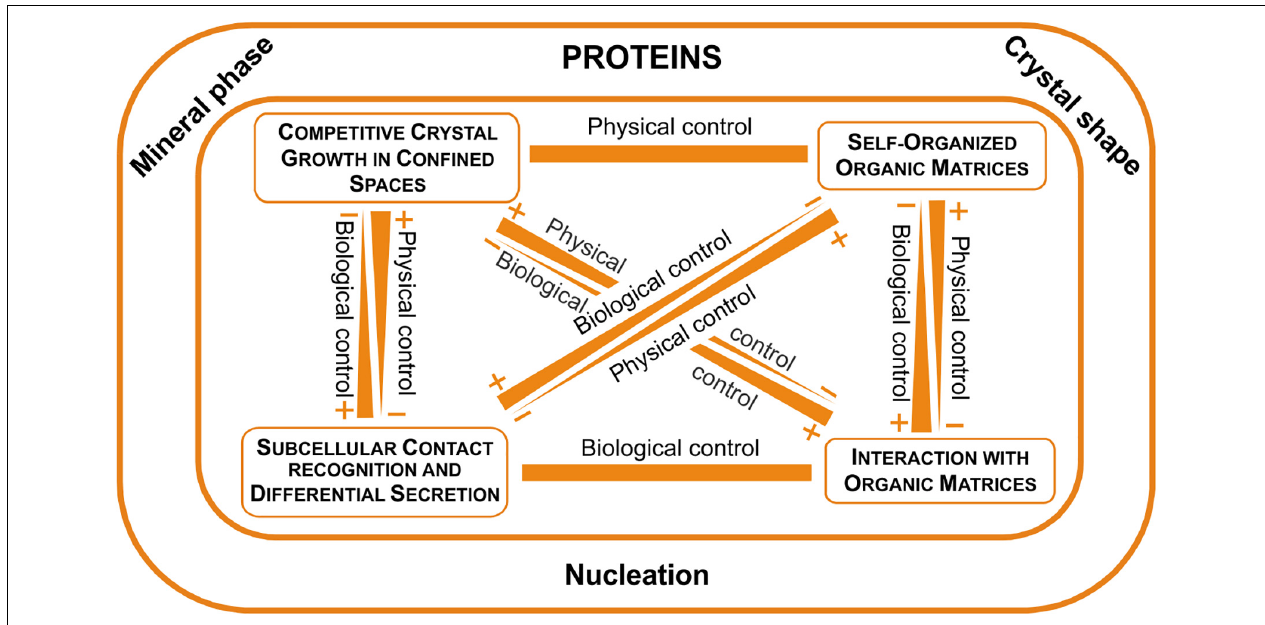
FIGURE 11 | The fabricational space of molluscan microstructures. Proteins clearly determine the mineral phase, crystal shape (with few exceptions) and nucleation, while other aspects of the fabrication process are determined by physical (crystal competition and self-organization), as well as biological determinants (interaction with organic matrices and direct cellular